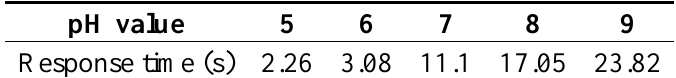
Table 1. Sensor response time under different pH